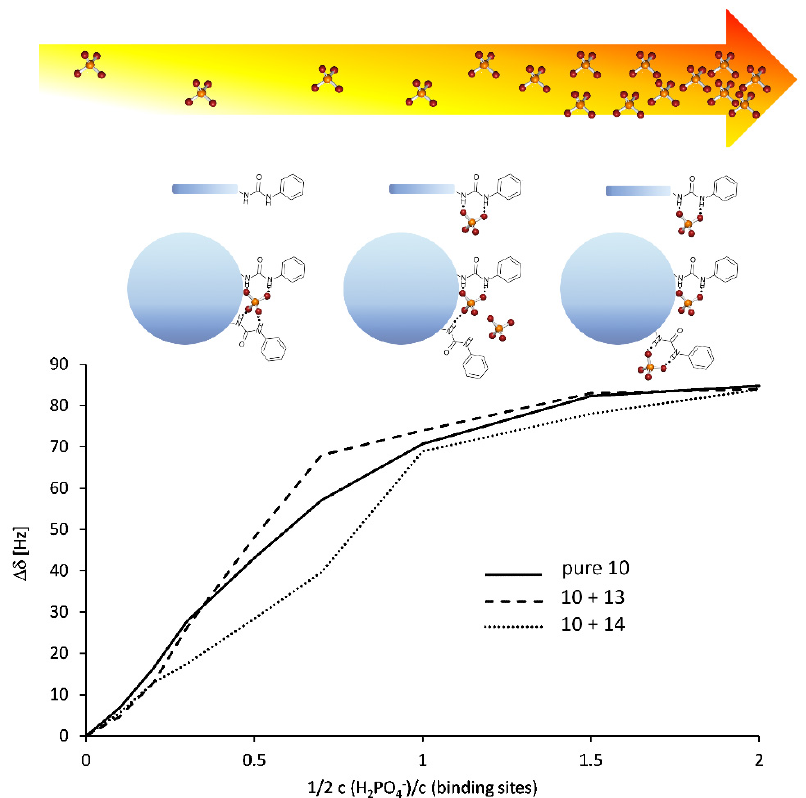
Figure 2. Comparison of H 2 PO 4 − binding isotherm of pure 10 with the corresponding binding isotherms of 10 in the presence of 13 and 14, respectively (shift of Ar H ; H at C3/5, Figure S64). For clarity, lines are used to connect the experimental data points.